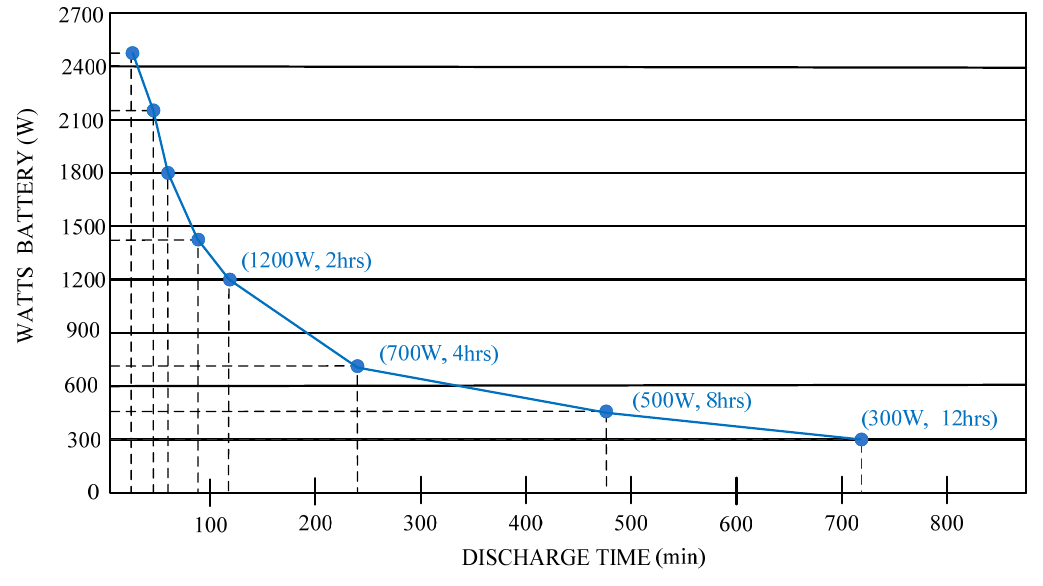
Figure 19. Plot of output power versus discharge time of the batteries supplied by battery manufacturer.